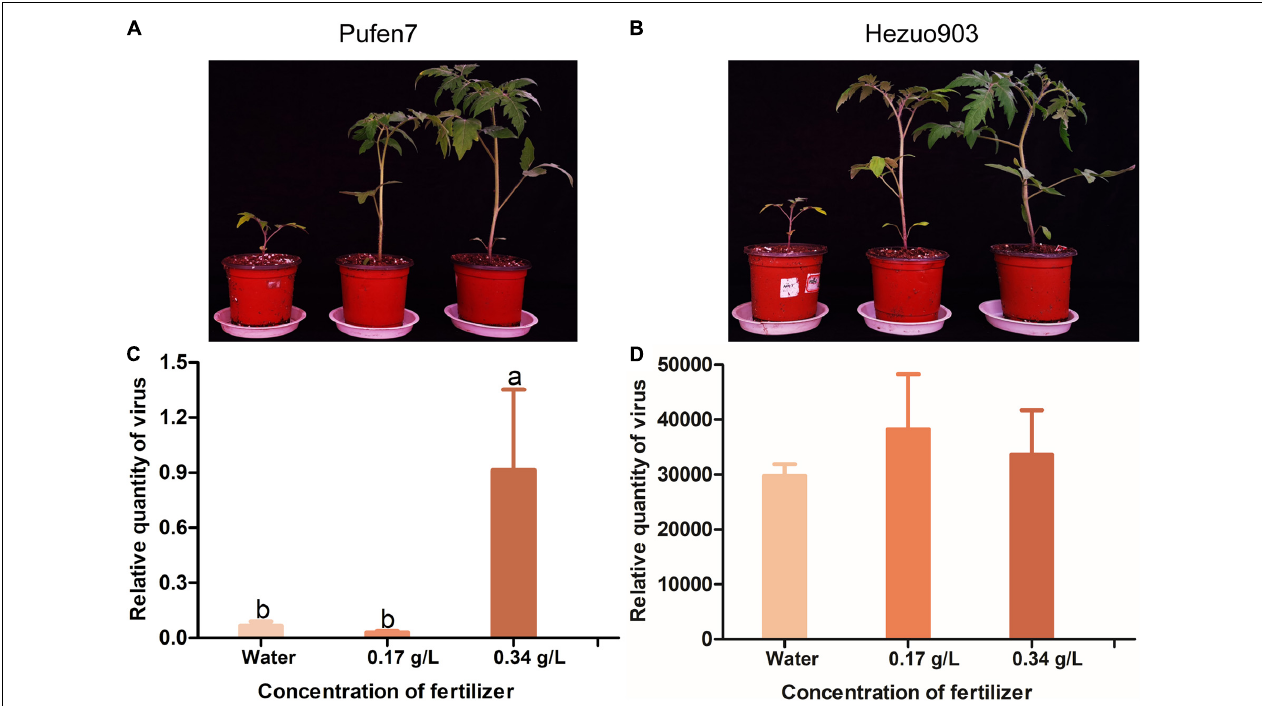
FIGURE 6 | Picture of tomato seedlings that were treated with water or solutions containing different concentration of fertilizer for 21 days and relative quantity of virus in these plants post agro-inoculation. (A) Pufen7 seedlings; (B) Hezuo903 seedlings; (C) Relative quantity of virus in Pufen7 plants; (D) Relative quantity of virus in Hezuo903 plants. Values are means ± SEM in panels (C,D) [ n = 15 for panel (C) and 8 for panel (D) ]. Different letters above the columns in panels (C,D) indicate significant differences (one-way ANOVA, p <